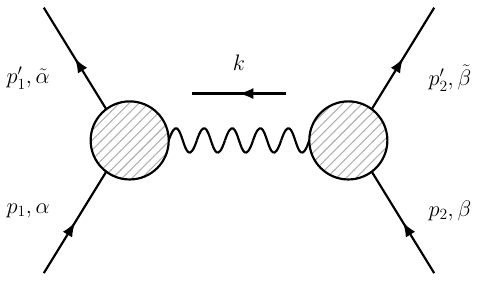
Figure 1 . Residue of tree-level four-point scattering amplitude in t